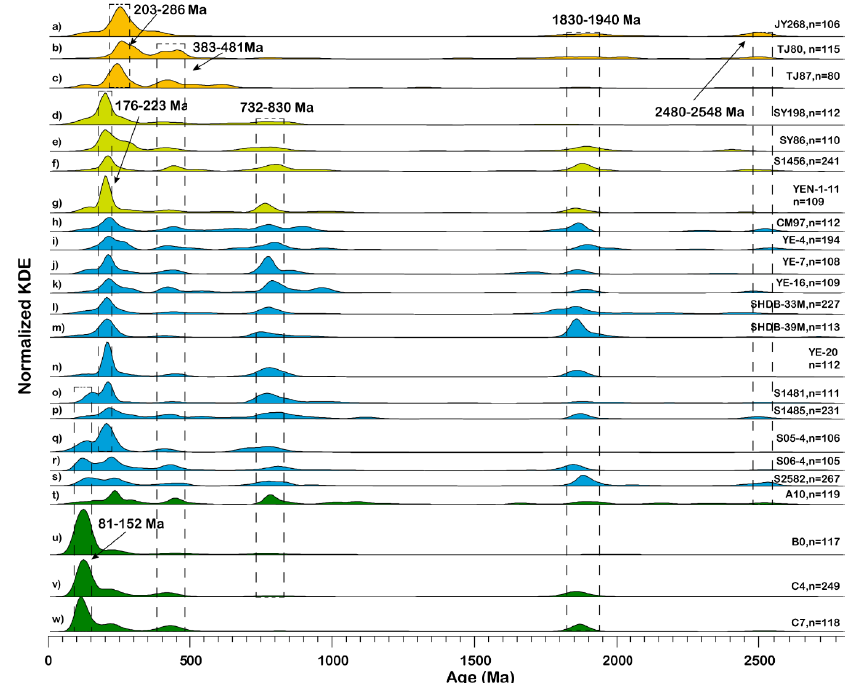
Figure 4. KDEs of detrital zircon U-Pb ages of in the ECSs. Different colors are used to represent the samples taken from different seas, with brown for the Bohai Sea ( a–c ), green-yellow for the Yellow Sea ( d – g ), blue for the East China Sea ( h – s ) and green for the northern South China Sea ( t – w ). The visually distinctive age populations are highlighted by the vertical dashed